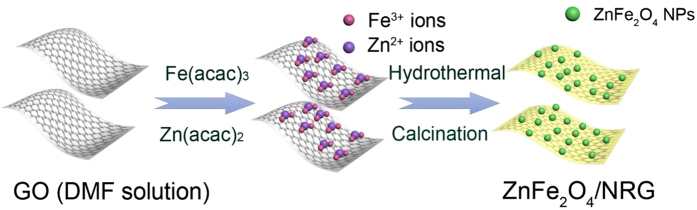
Schematic illustration for the preparation of ZnFe2O4/NRG composite.